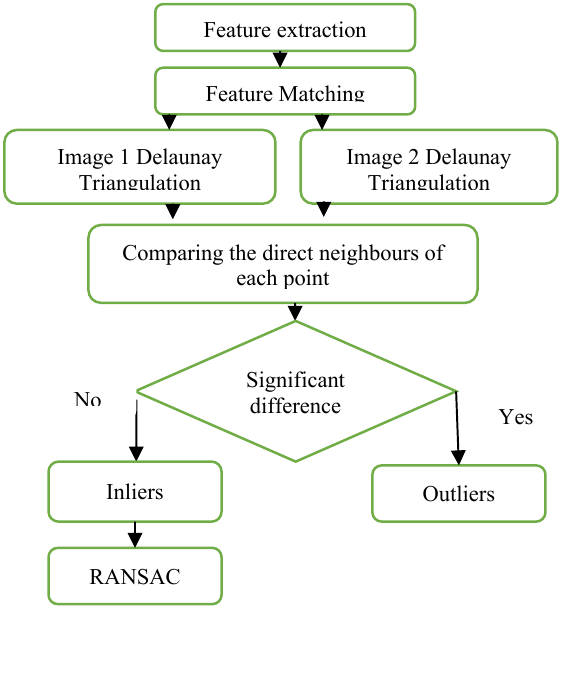
Figure 8 : Algorithm I graph network